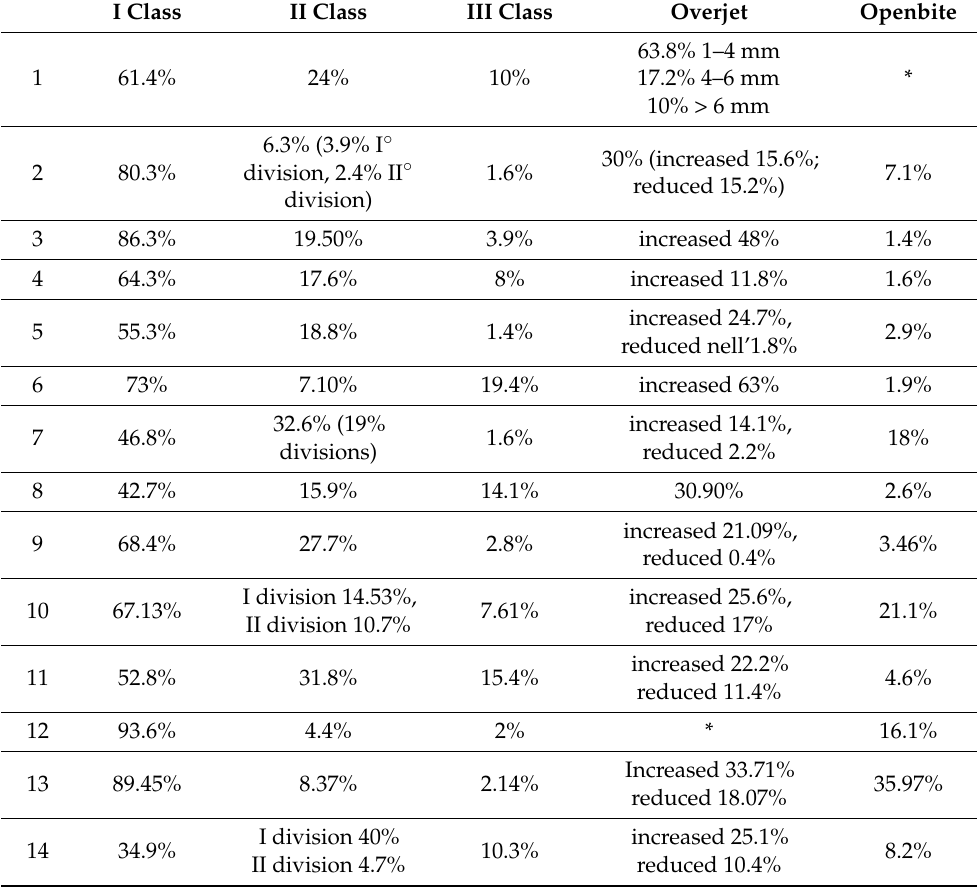
Table 2. Class I, Class II, Class III, overjet, openbite prevalence for each study. (* the anomaly considered was not